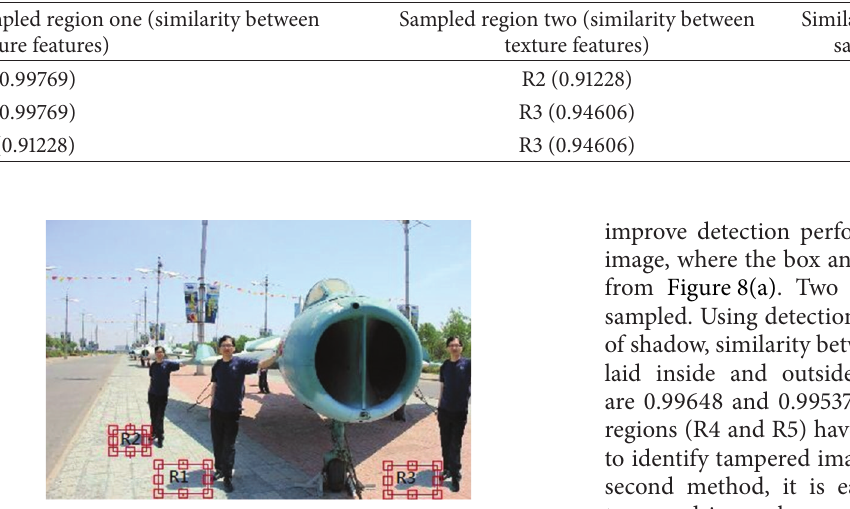
Table 3: Detection results on image in Figure 10.